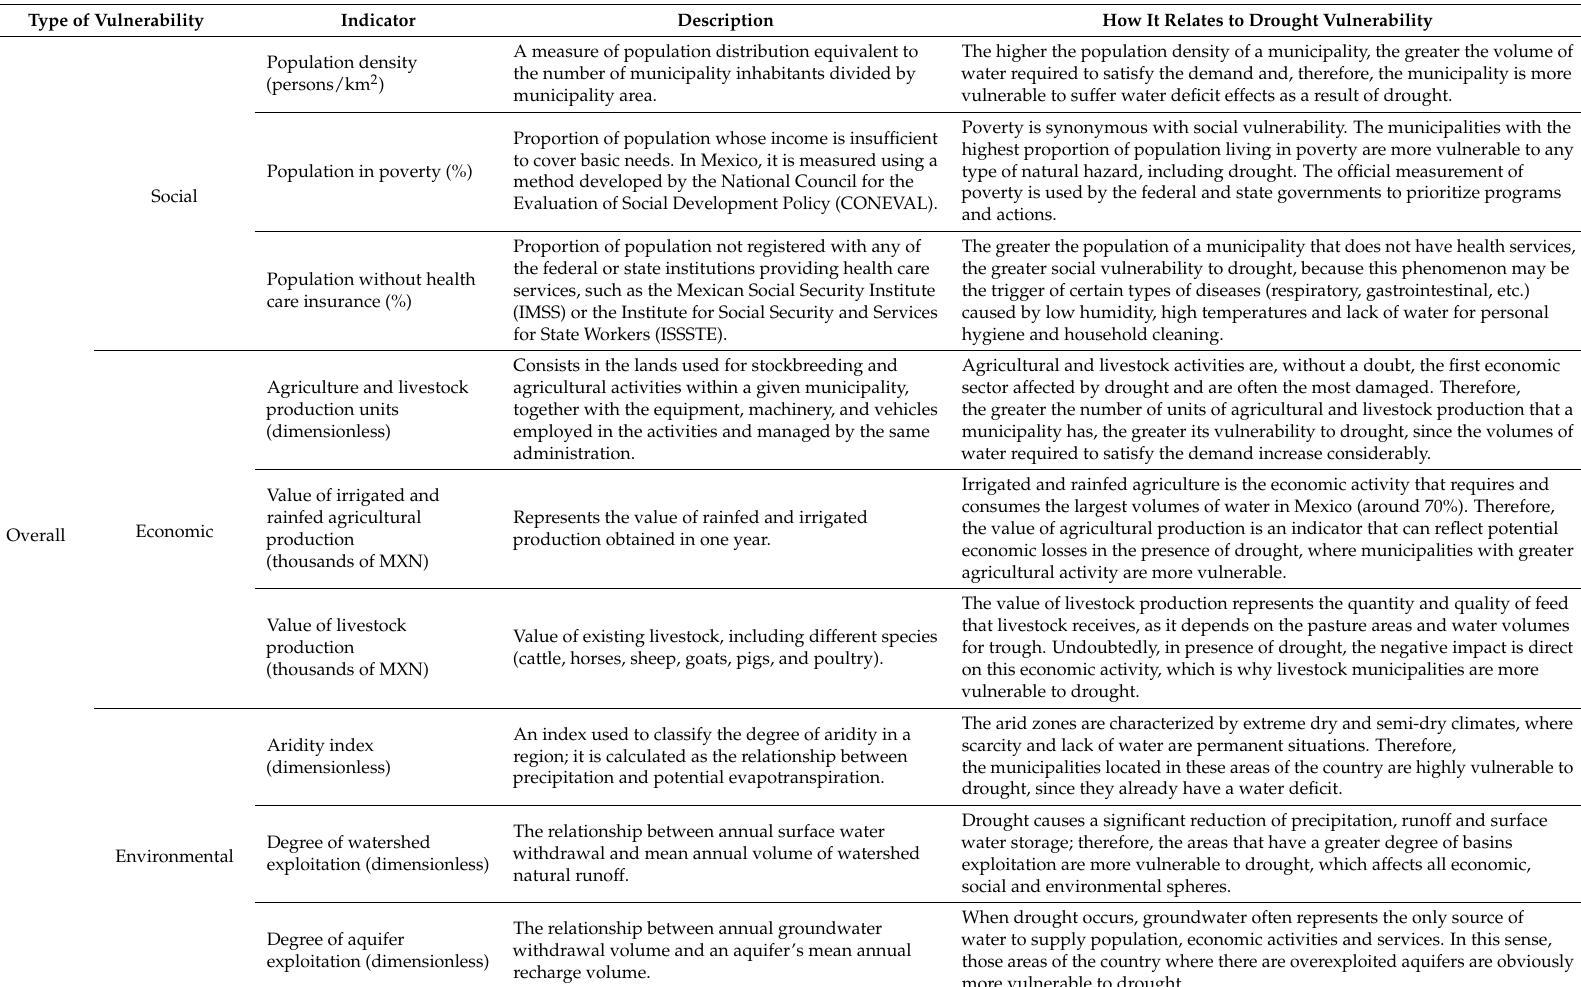
Table 2. Indicators of degree of exposure to